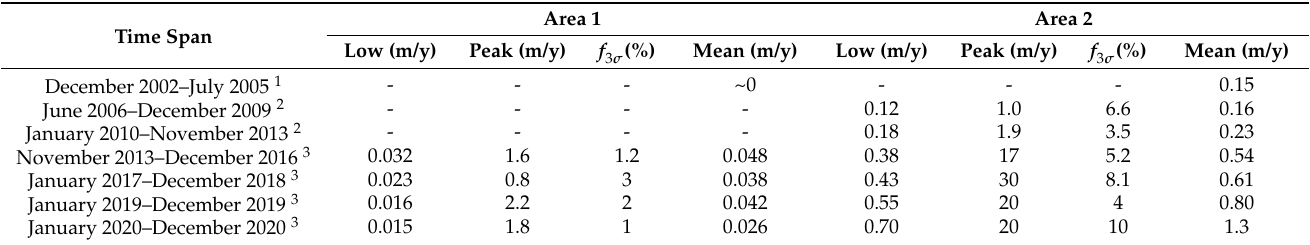
Table 1. Main data about kinematics of Perarolo landslide for each recognized area: low velocity (i.e., mean velocity without rainfall triggering); peak velocity, fraction of episodes where the velocity exceeds three times the corresponding velocity standard deviation ( f 3 σ ), mean velocity in the complete time